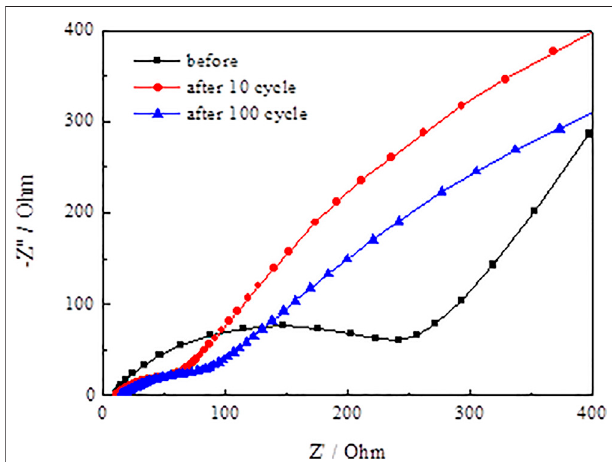
FIGURE 13 | Nyquist plots of SnO 2 @C.